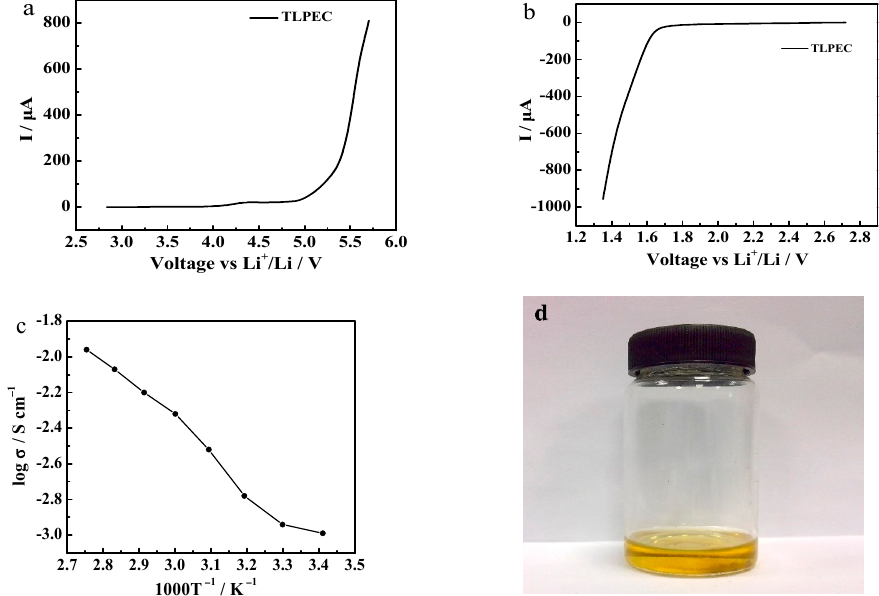
Figure 3. ( a ) LSV curve of TLPEC from 2.8 V to 5.6 V. ( b ) LSV curve of TLPEC from 2.8 V to 1.4 V. ( c ) Ionic conductivities of TLPEC as a function of temperature. ( d ) The photo of TLPEC.